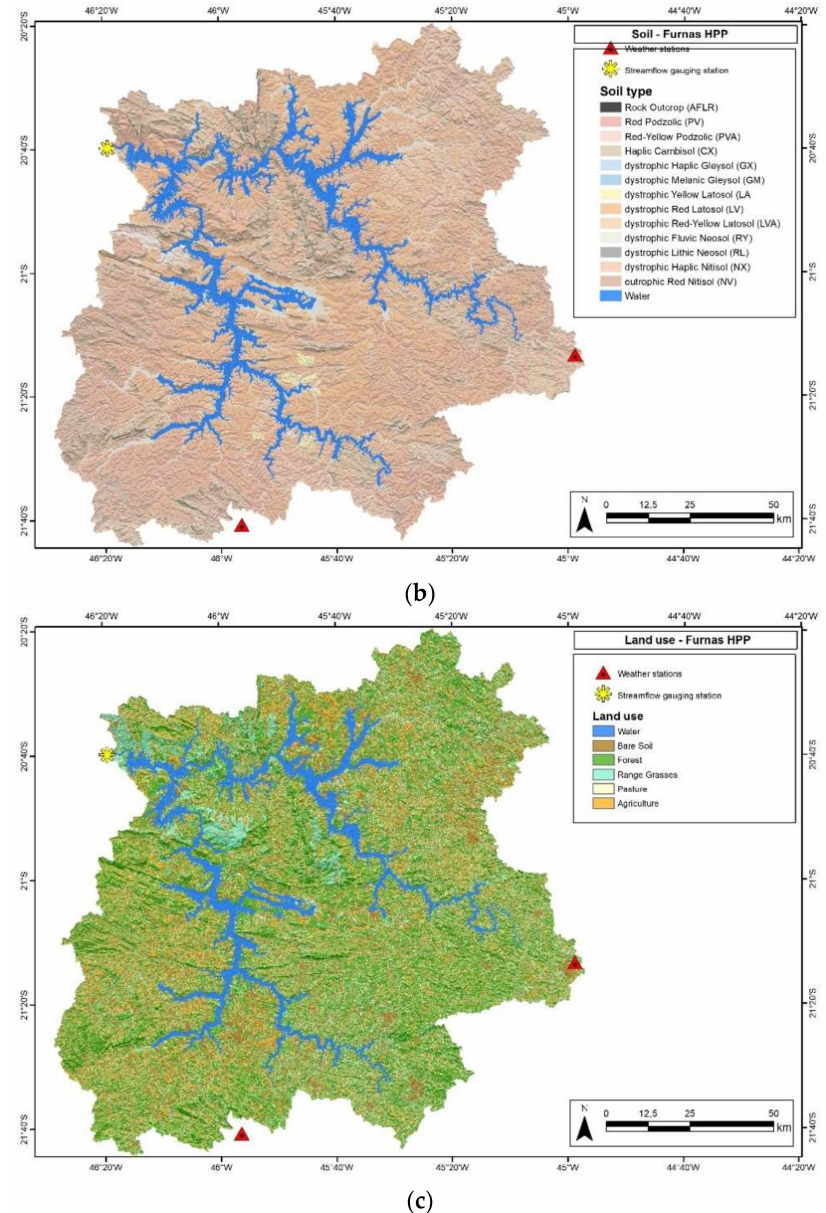
Figure 2. Spatial input data. ( a ) Digital elevation model (DEM); ( b ) Soils; ( c ) Land